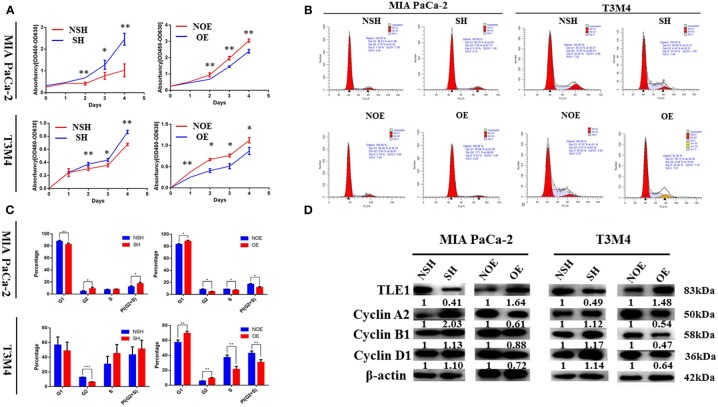
TLE1 hampers PDAC cell proliferation and cell cycle progression in vitro. (A) PDAC cell proliferation was evaluated by CCK-8 assays in MIA PaCa-2 and T3M4 cells. (B,C) Cell cycle progression was detected using flow cytometry, and the percentages of G1, G2, and S phase cells in the MIA PaCa-2 and T3M4 cell lines were calculated. (D) Levels of critical cell cycle regulators were evaluated by western blot. Data are presented as mean ± SD. *P < 0.05, **P < 0.01, ***P < 0.001, by Student's t-test. CCK-8, Cell Counting Kit-8; TLE1, transducin-like enhancer of split-1; PDAC, pancreatic ductal adenocarcinoma; OE, TLE1 overexpression; NOE, negative control for TLE1 overexpression; SH, TLE1 knockdown; NSH, scrambled control (n = 3).